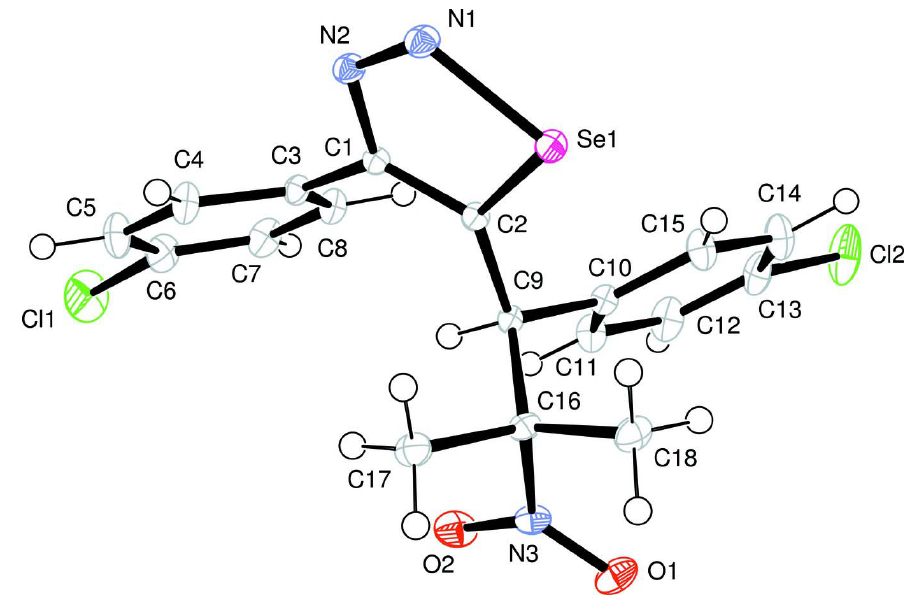
Figure 1 The molecular structure of (I), with atom labels and 50% probability displacement ellipsoids for non-H